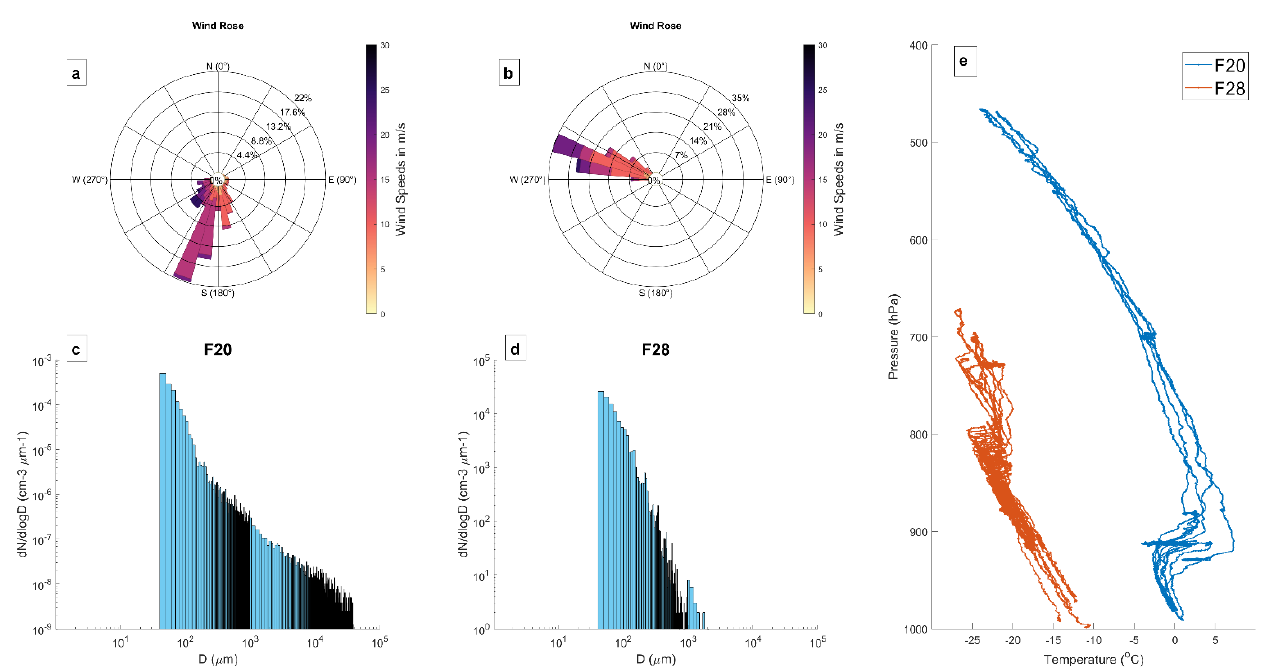
Figure 3. GOES-16, 11.2 µm infrared satellite imagery of representative time windows, in the middle of the flights. ( a ) F20, ( b ) F28. The images were obtained from the Satellite Cloud and Radiation Property retrieval System (SatCORPS) Team, http://satcorps.larc.nasa.gov (accessed on 1 January 2021).